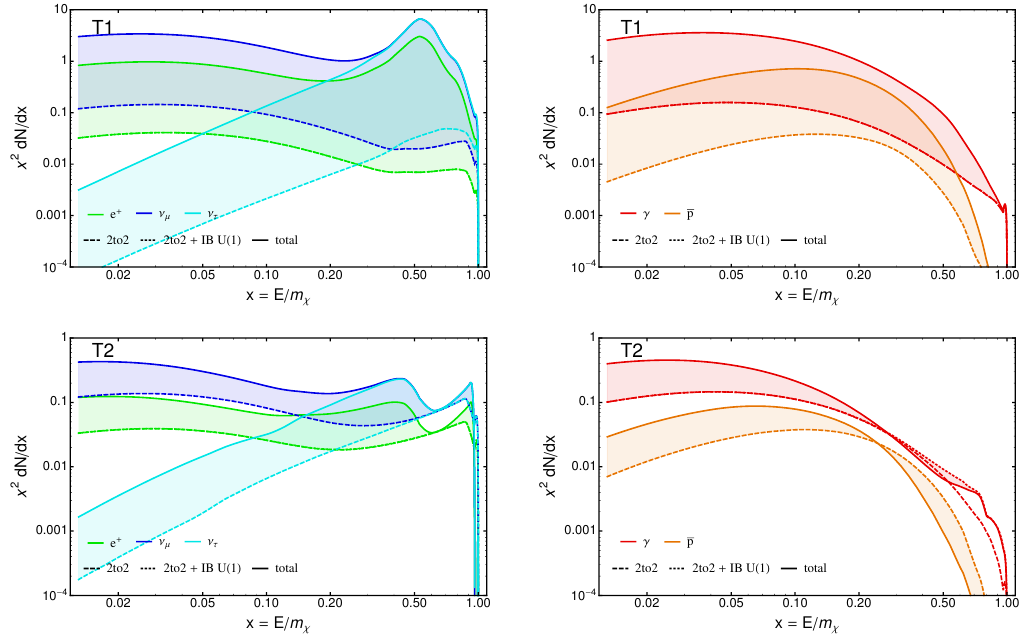
Figure 13 . Same as (cid:12)gure 11, but for a W threshold model (T1, top) and a top-quark threshold model (T2, bottom). The features in the shape of the lepton and gamma ray spectra are due to an interplay of various e(cid:11)ects as discussed in detail in the